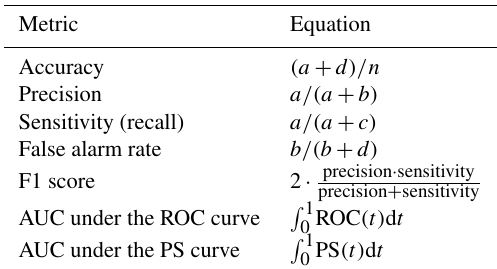
Table 5. Key metrics for the evaluation of model performance; a , b , c and d are defined in Table